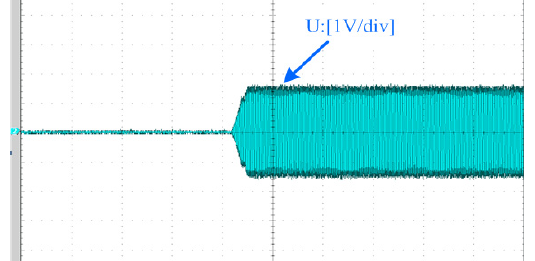
Figure 12. The waveform of the detected voltage under the copper sheet.